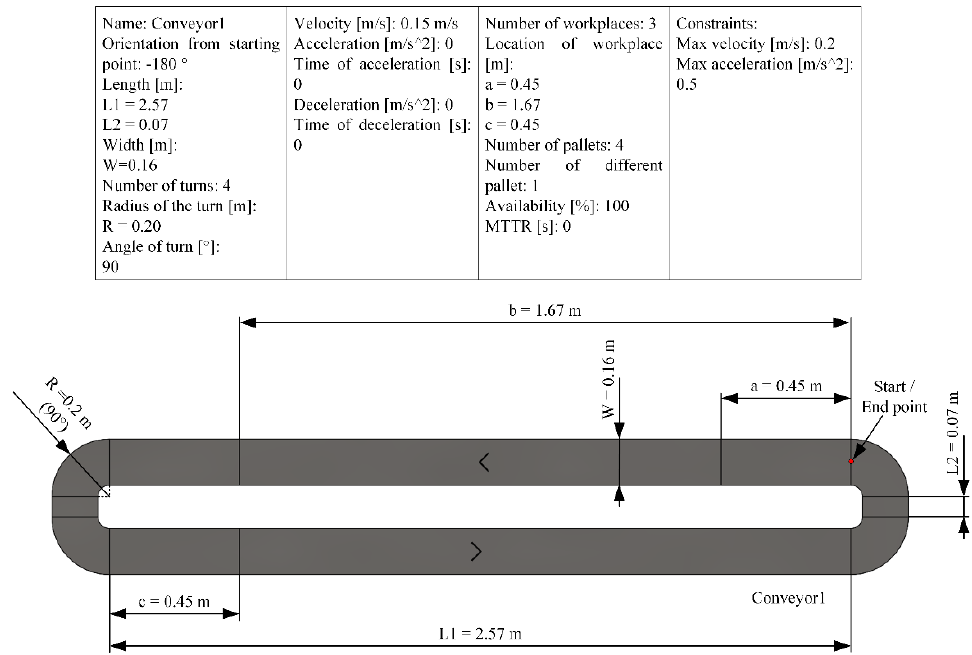
Figure 13. Values used for the digital model of the conveyor.